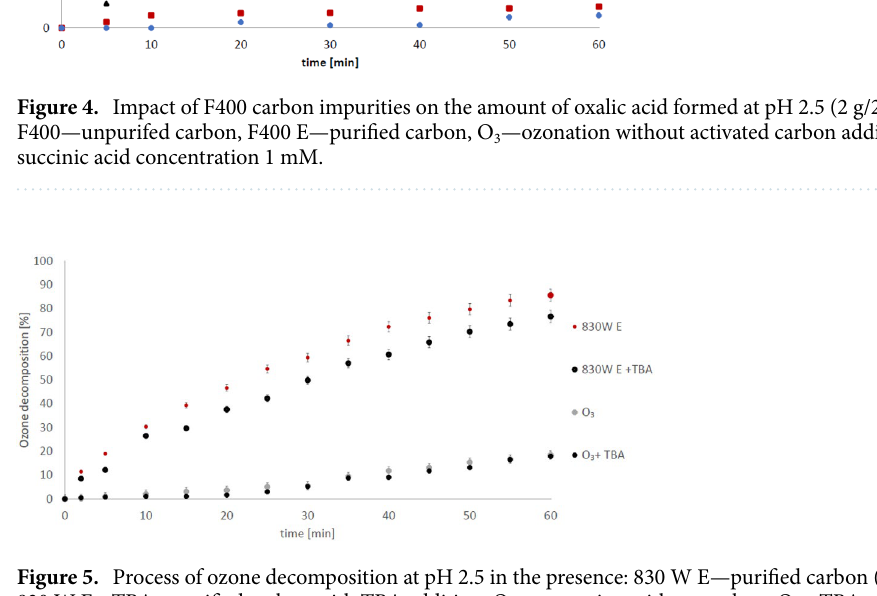
Figure 5. Process of ozone decomposition at pH 2.5 in the presence: 830 W E—purified carbon (0.5 g/200 ml); 830 W E + TBA—purified carbon with TBA addition; O 3 —ozonation without carbon, O 3 + TBA—ozonation without carbon in the presence of TBA. E—purified carbon).